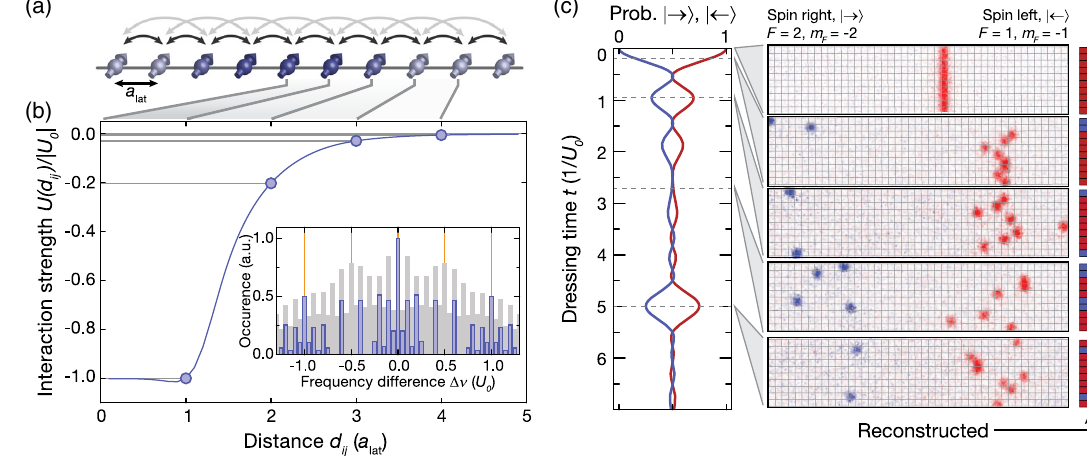
FIG. 1. Schematic of the Ising spin chain and spin-selective detection. (a) Illustration of a spin chain with N ¼ 10 spins initialized in the fully transverse magnetized state. The dominant contributions of the Rydberg-dressed interaction between nearest and next-to- nearest spins spaced by a are indicated by the dark gray and light gray arrows. The brightness of the blue color of the spins encodes the lat interaction strength between the exemplary selected fifth spin with the rest of the chain. The gray lines are guides to the eye to link to the interaction potential shown in (b). (b) Ab initio calculated Rydberg-dressed potential [18] for our experimental parameters Ω = 2 π ¼ 3 . 57 ð 3 Þ MHz and Δ = 2 π ¼ 11 . 00 ð 2 Þ MHz, normalized to the nearest-neighbor interaction strength j U j ¼ 13 . 1 ð 5 Þ kHz (blue solid 0 line), with the relevant potential at multiples of the lattice distance a marked by blue points and gray horizontal lines. The inset shows lat the occurrence of frequency differences Δ ν in the many-body spectrum of the long-range interacting Ising model (gray bars) and those governing transverse magnetization dynamics (blue bars). Orange vertical lines mark the corresponding Δ ν for the Ising model with nearest-neighbor interactions only. (c) Simulated revival dynamics of the populations of spin left (red) and spin right (blue), starting from the initially fully magnetized chain in the S y direction for a defect-free chain of ten spins and long-range interactions. Clear partial revivals are observed during the evolution. The fluorescence images to the right show characteristic spin configurations for ten spins observed during the collapse and revival dynamics at times indicated by the gray lines. The spin of the atoms was detected via an in situ Stern-Gerlach sequence, which led to a spatial separation of spin-left (red) and spin-right atoms (blue). This allows for the reconstruction of the full spin and density distribution (pictograms to the